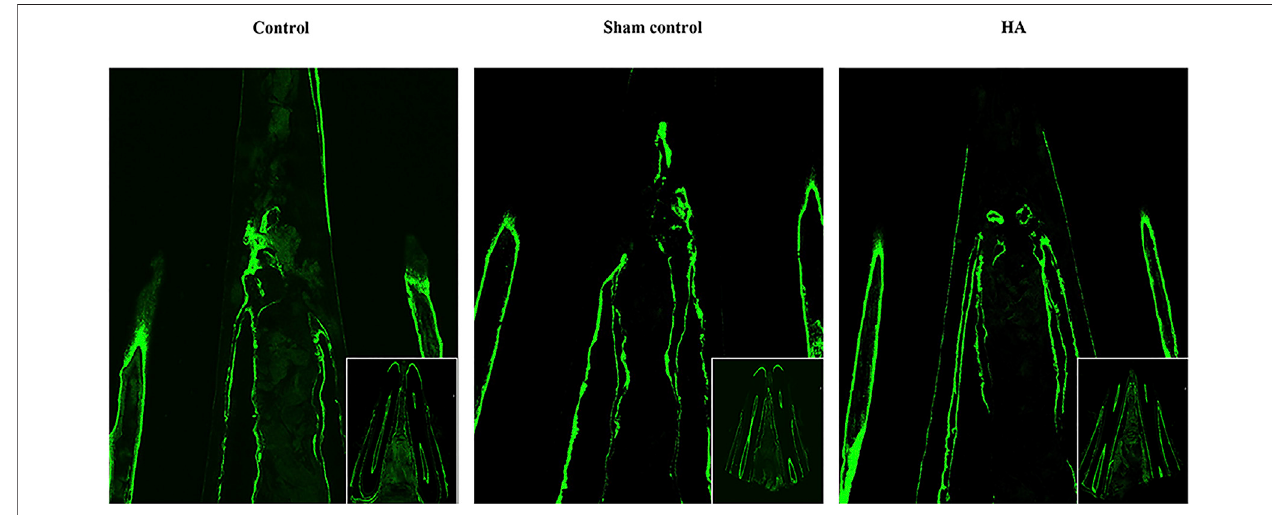
FIGURE 5 | Dynamic labeling of the pristine alveolar bone. Dynamic labeling alveolar bone regeneration in representative tissue sections 8 weeks postinjection of the control group (A) , sham control group (B), and HA group (C) , n (cid:1) 5.